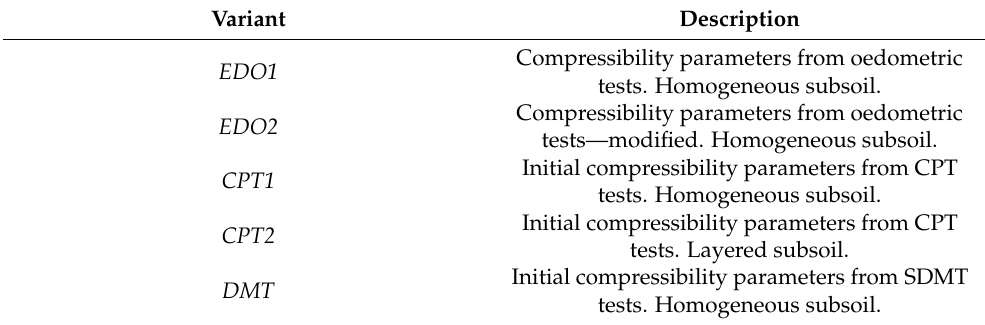
Table 3. Variants of subsoil parameters in the Modified Cam-Clay model.